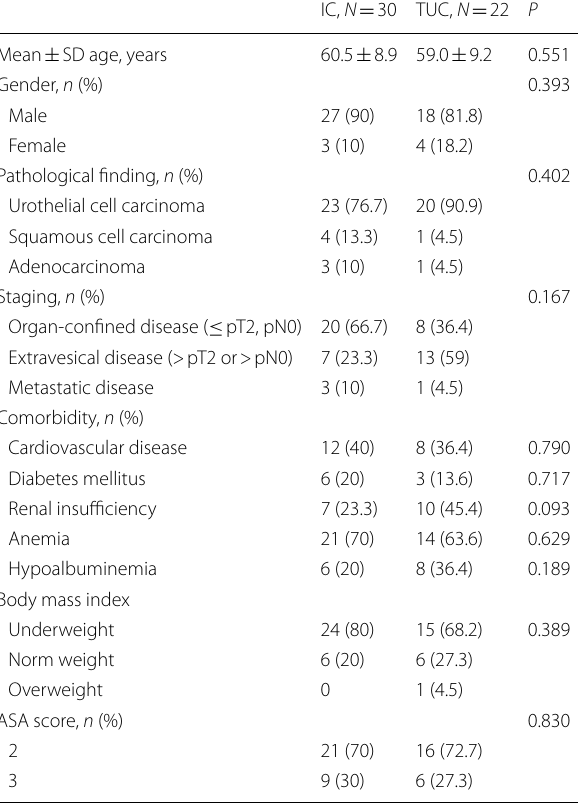
ASA American Society of Anesthesiologist, IC ileal conduit, TUC transuretero- cutaneostomy All statistical analyses in this table used Chi-squared